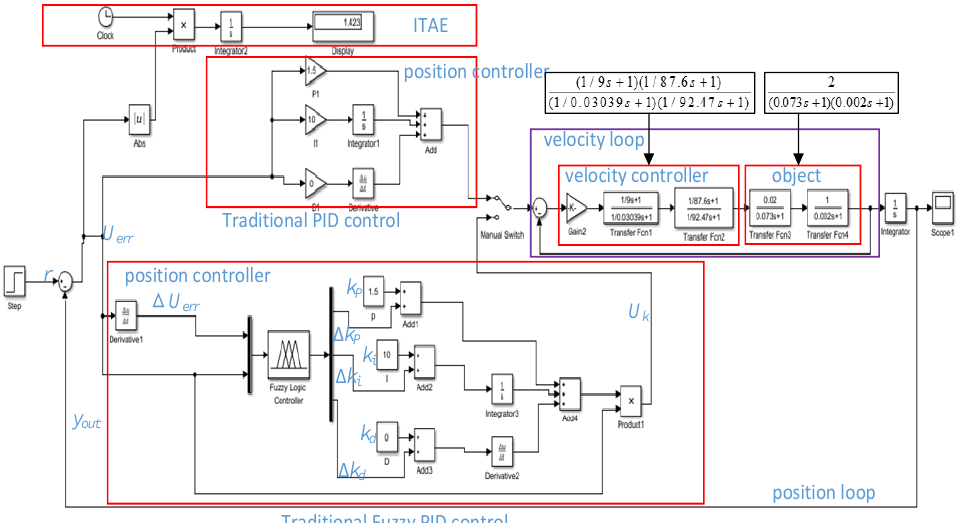
Figure 2. Position and velocity double closed-loop control